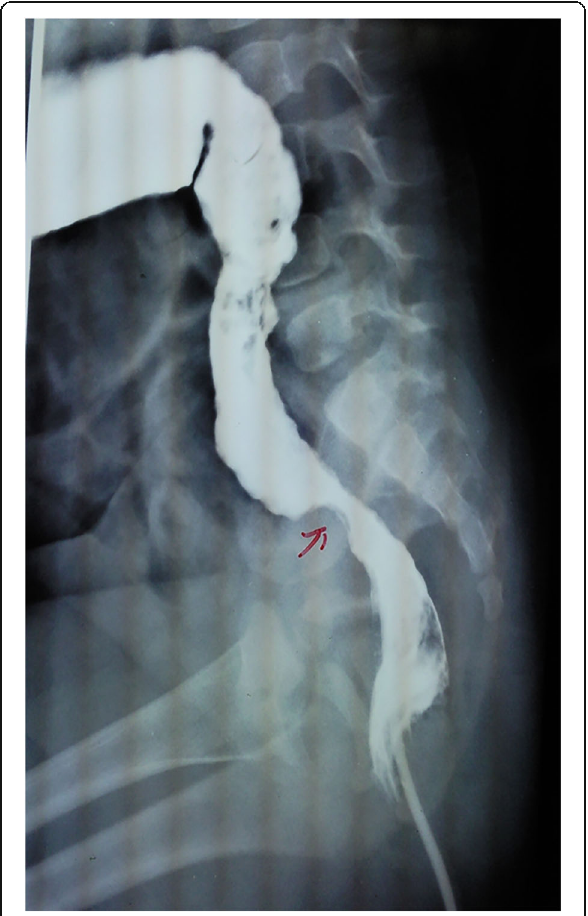
Fig. 1 Gastrografin enema of a child after a trans-anal endorectal pull-through showing. An indentation in the pulled-through colon caused by a long muscular